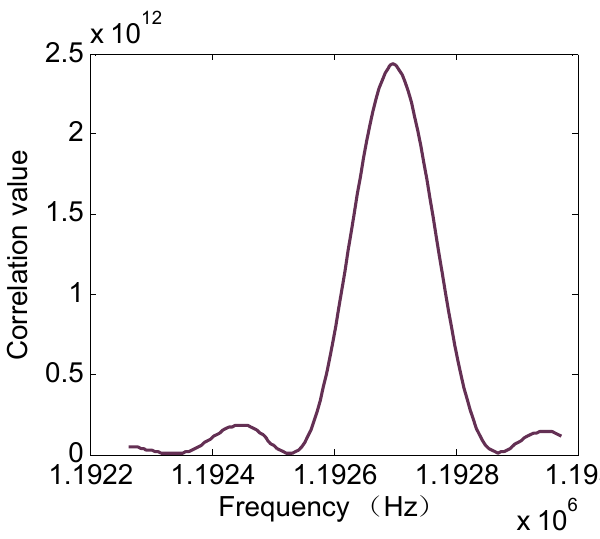
Figure 7. Correlation results between local carrier and real signal.